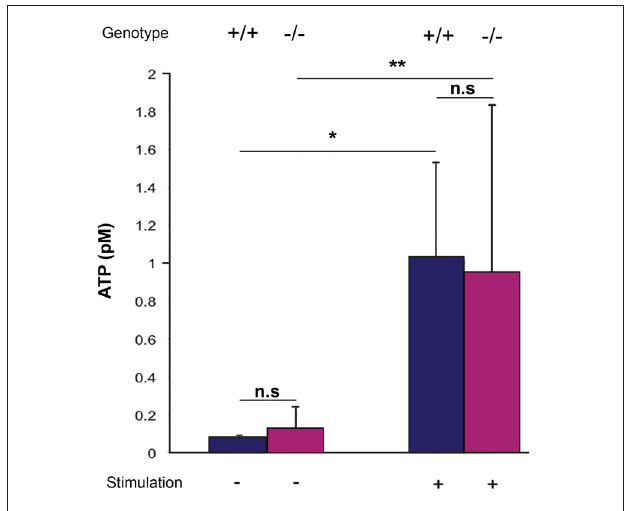
FIGURE 5 | Quantification of extracellular ATP after mechanical stimulation of the VNO. ATP release from the VNO of wild-type and knock out animals was determined as outlined in materials and methods using a luminescent ATP detection assays. Without stimulations, very low levels of ATP were detectable, with no differences between the two genotypes. Mechanical stimulation significantly increased ATP release, again, with no difference between wild-type and Panx1 − / − animals. Error bars indicate standard deviation. ∗ p < 0.01, ∗∗ p < 0.05.